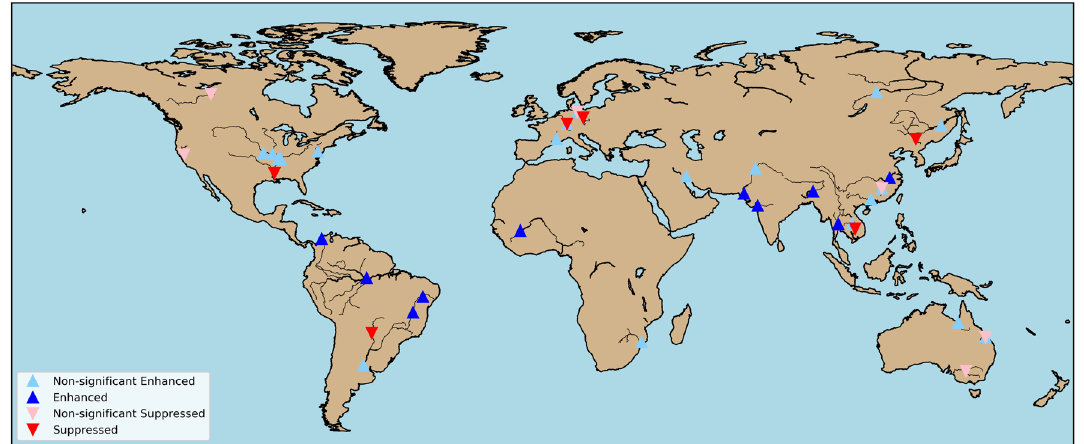
Figure 1. Global distribution of flood events included in this study. This figure was created using Python (3.9.7) and the Basemap library